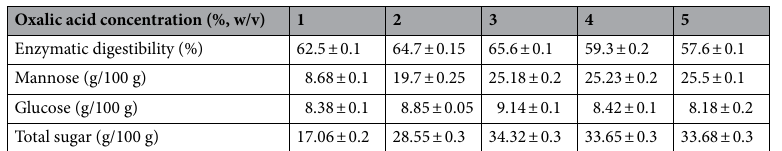
Table 2. Sugar released after oxalic acid pretreatment followed by enzymatic hydrolysis at 72 h.